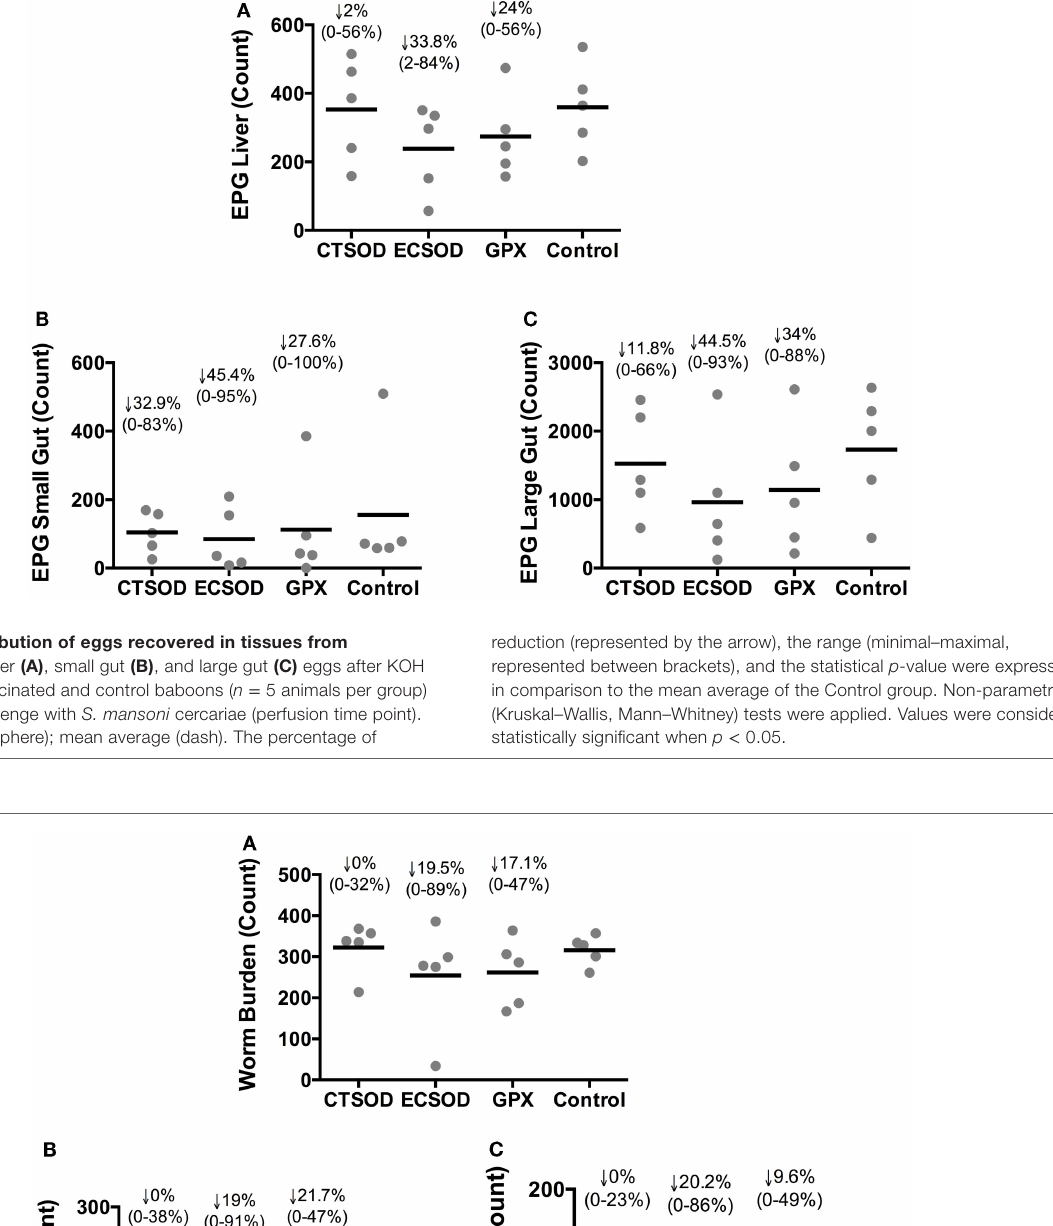
Figure 5 | Distribution of worms recovered (worm burden) from experiment 2 . Total worm burden (a) , male (B) and female (c) worm count. Worms from vaccinated and control baboons ( n = 5 animals per group) 10 weeks after challenge with S. mansoni cercariae (perfusion time point). Individual values (sphere); mean average (dash). The